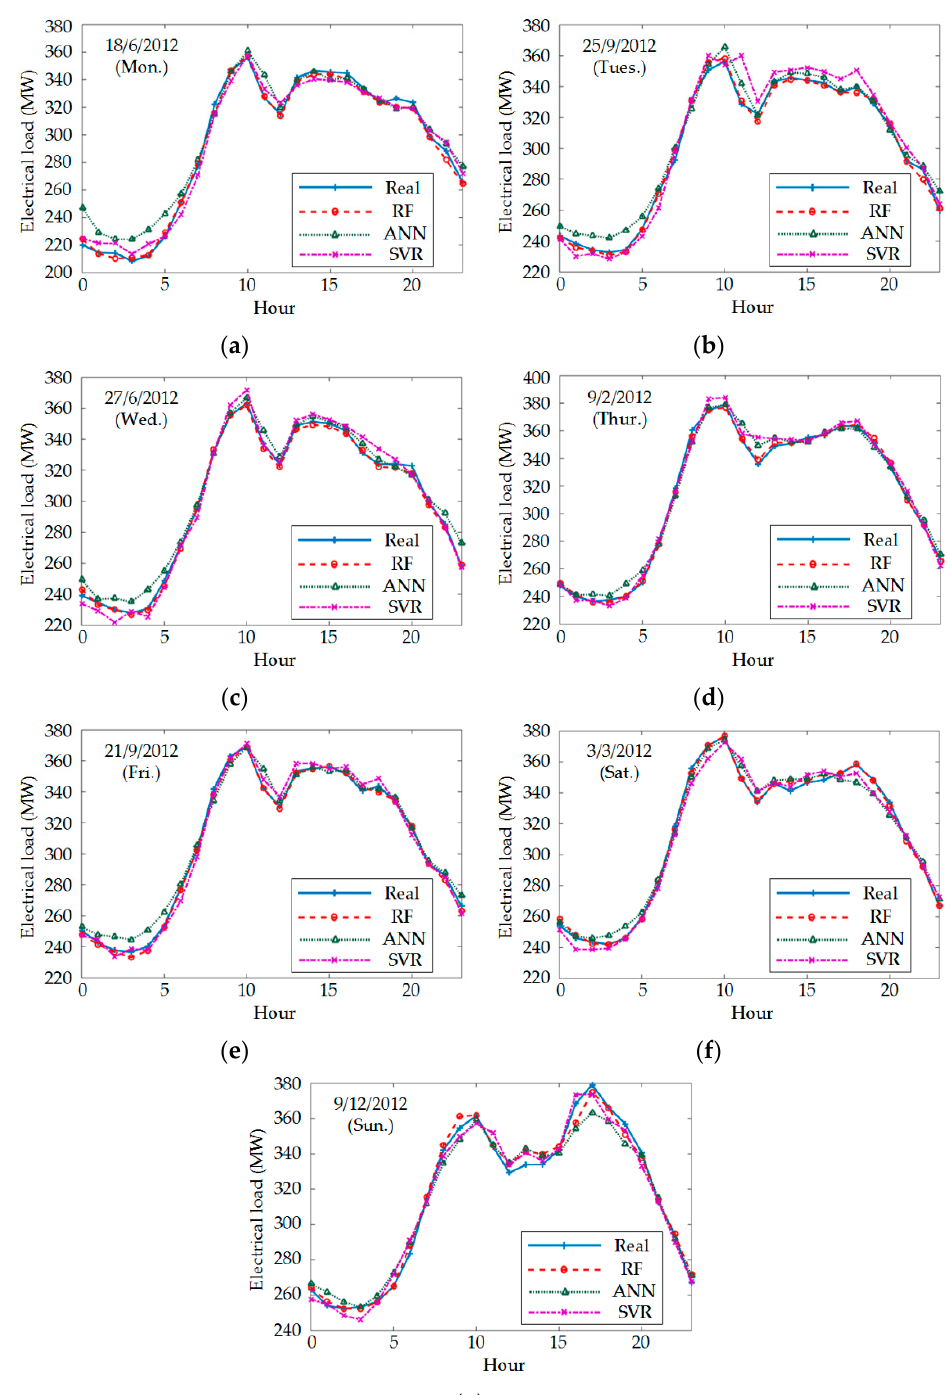
Figure 7. ( a ) The comparison of prediction results obtained from 1 ‐ h ‐ ahead prediction of June 18th; ( b ) the comparison of prediction results obtained from 1 ‐ h ‐ ahead prediction of September 25th; ( c ) the comparison of prediction results obtained from 1 ‐ h ‐ ahead prediction of June 27th; ( d ) the comparison of prediction results obtained from 1 ‐ h ‐ ahead prediction of February 9th; ( e ) the comparison of prediction results obtained from 1 ‐ h ‐ ahead prediction of September 21st; ( f ) the comparison of prediction results obtained from 1 ‐ h ‐ ahead prediction of March 3rd; ( g ) the comparison of prediction results obtained from 1 ‐ h ‐ ahead prediction of December 9th.